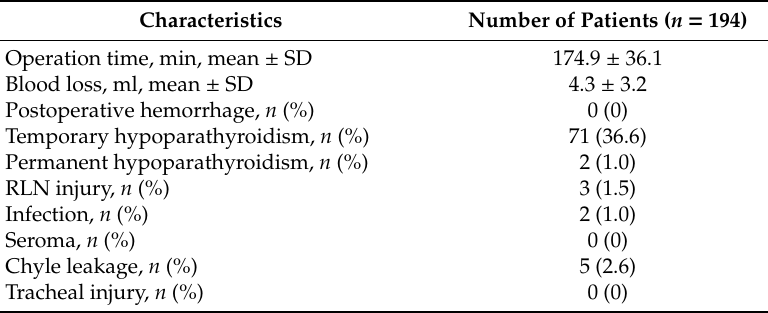
Table 2. Technical outcomes of robotic thyroid surgery.